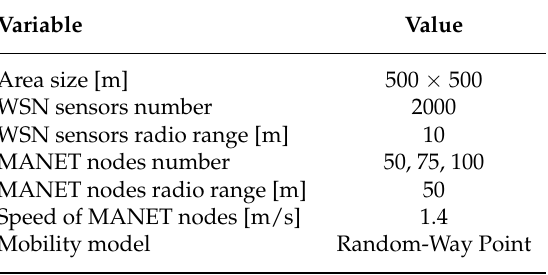
Figure 18. Example of simulation scenario 3. The brown circles are illustrations of MANET node’s radio ranges. Table 3. Scenario 3 simulation